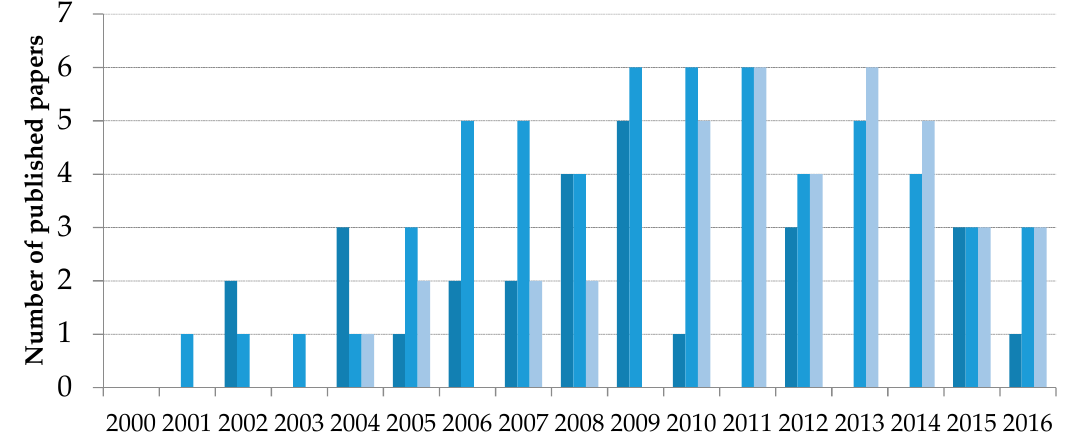
Figure 5. Published articles per year distributed according to the forecasting methodology used (in the observed sample of scientific articles).